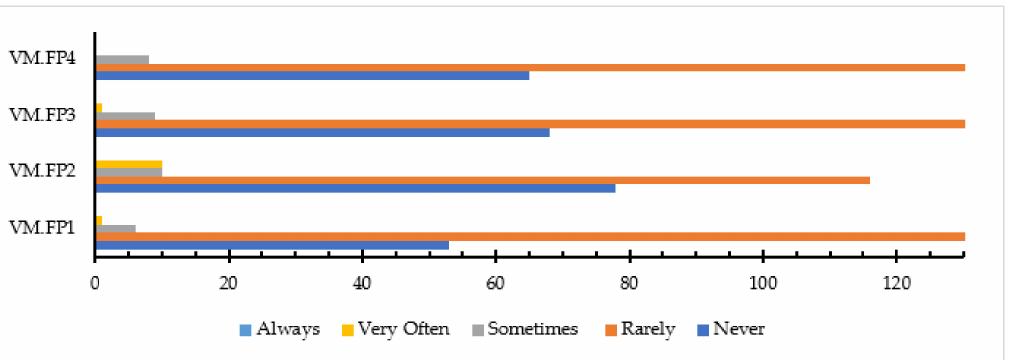
Figure 5. Frequency distribution for the information phase.